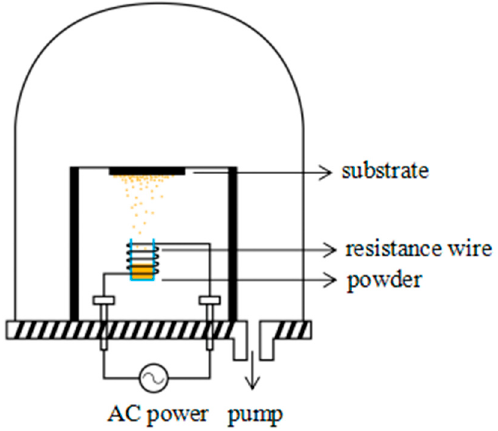
Figure 1. Schematic description of the vacuum thermal evaporation system.